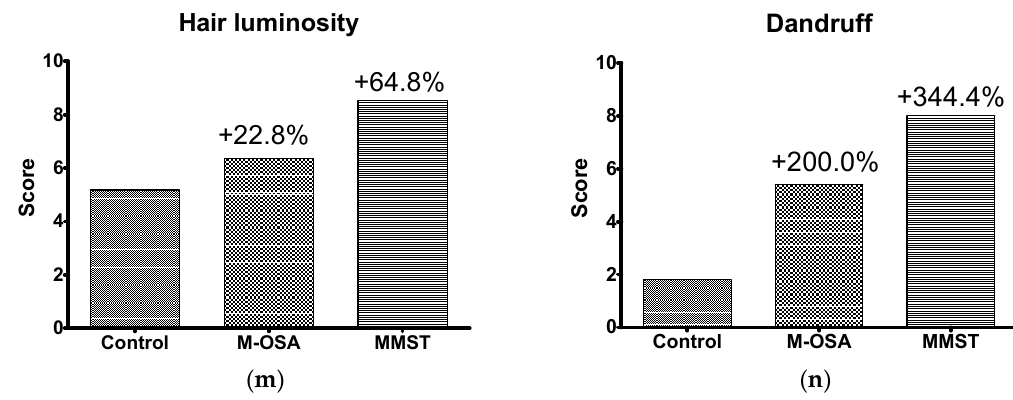
Figure 4. Comparison of means of self-efficacy questionnaire variables as a function of group at the end of the study (T5). ( a ) skin general appearance; ( b ) skin hydration; ( c ) homogeneity of skin color; ( d ) darkened areas—intensity; ( e ) darkened areas—quantity; ( f ) skin imperfections; ( g ) skin luminosity; ( h ) hair hydration; ( i ) hair nutrition; ( j ) hair softness; ( k ) hair vitality; ( l ) hair aging signals.; ( m ) hair luminosity; ( n ) dandruff. All parameters listed showed significance differences between both treatments and the control.